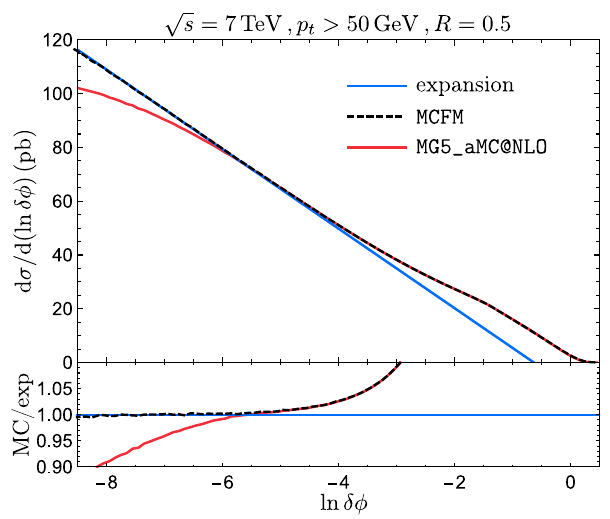
Figure 5 . Comparison between the differential distributions d σ/ d(ln δφ ) obtained by expanding the resummed distribution up to O ( α ) and fixed-order programs MadGraph5_aMC@NLO and MCFM s